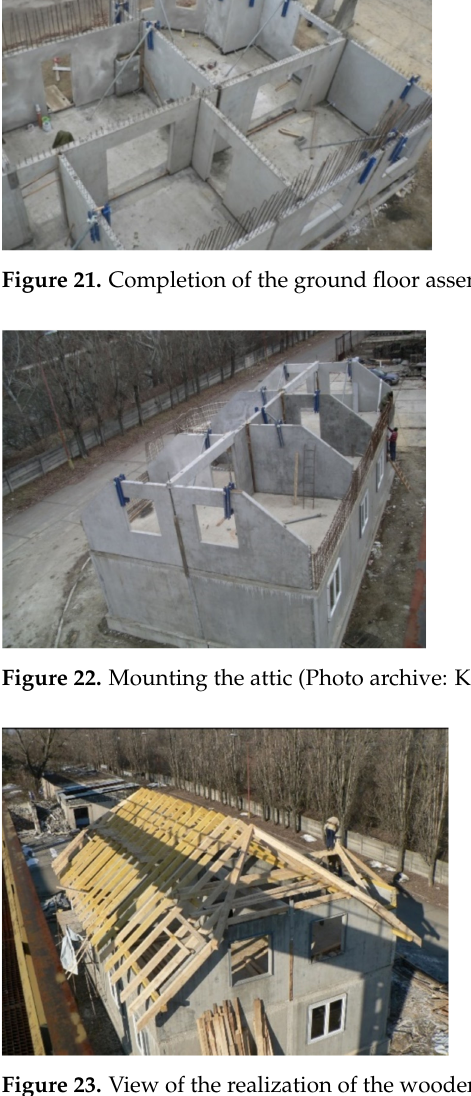
Figure 23. View of the realization of the wooden truss. (Photo archive: Kal ú s, D.)